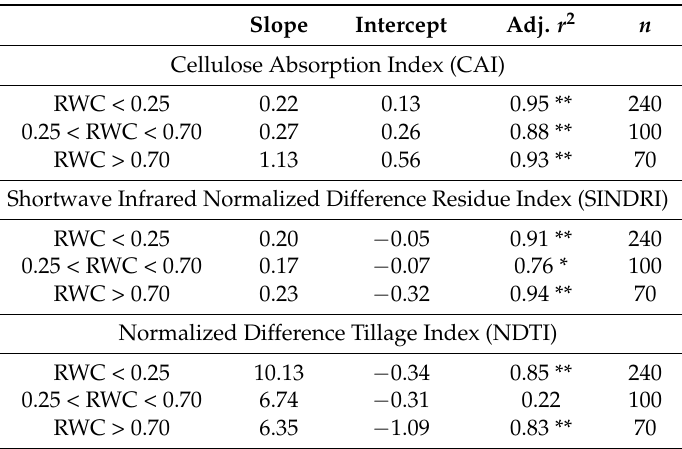
Table 5. Regression coefficients and adjusted coefficient of determination (Adj. r 2 ) of the linear models fitted to the fraction of residue cover measured in the field and the spectral residue indices (CAI, SINDRI and NDTI) when the data were separated into groups based on their RWC. Slope Intercept Adj. r 2